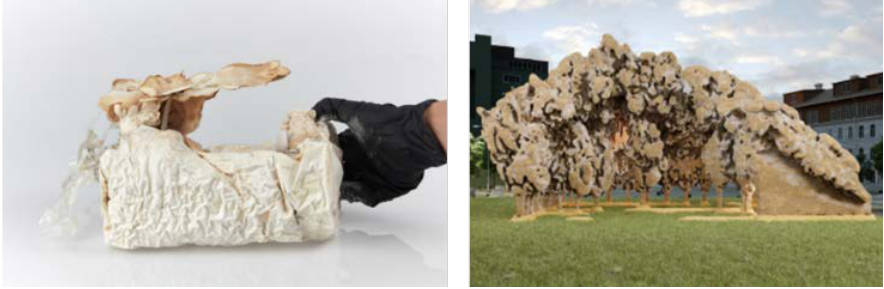
Figure 18 Talinn Architecture Biennale-2022